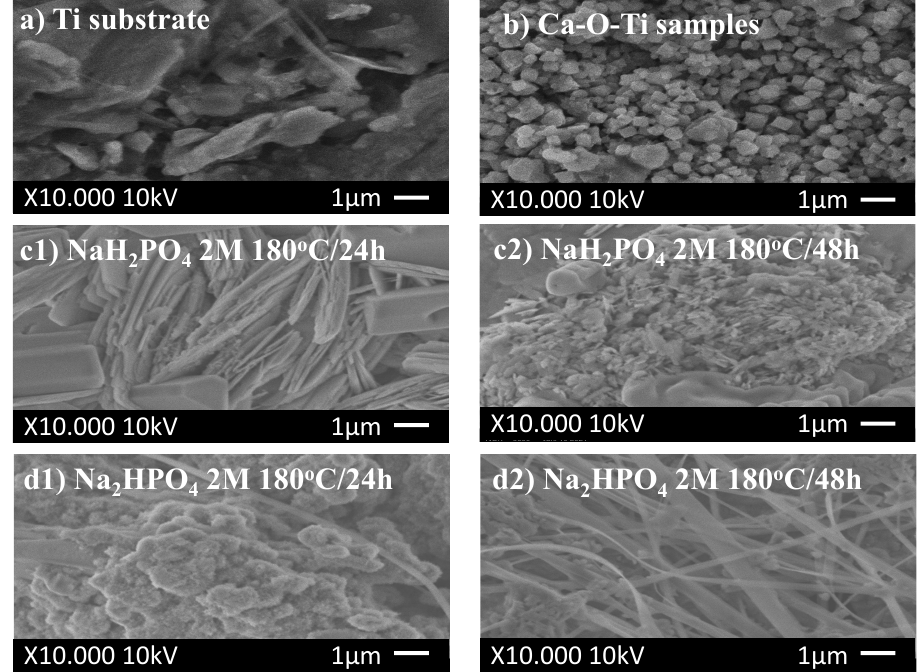
Figure 4. SEM images of ( a ) Ti bar; ( b ) Ca–O–Ti bar; and when hydrothermal treated at different phosphate solutions such as ( c1 , c2 ) NaH 2 PO 4 2 M at 180 °C for 24 and 48 h; ( d1 , d2 ) Na 2 HPO 4 2 M at 180 °C for 24 and 48 h.